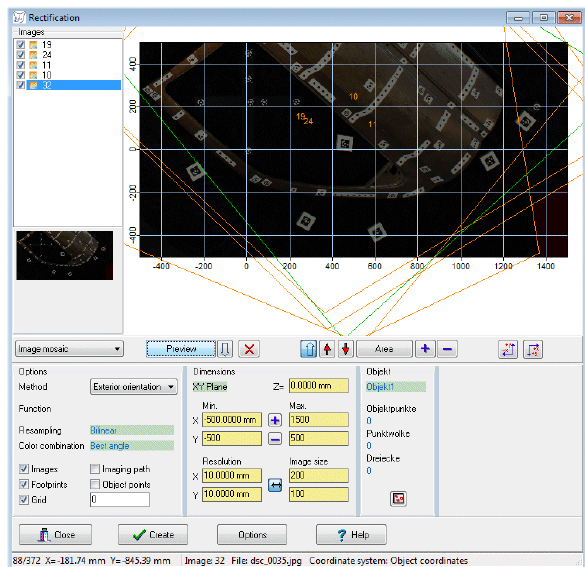
Figure 6: Rectification and mosaicing